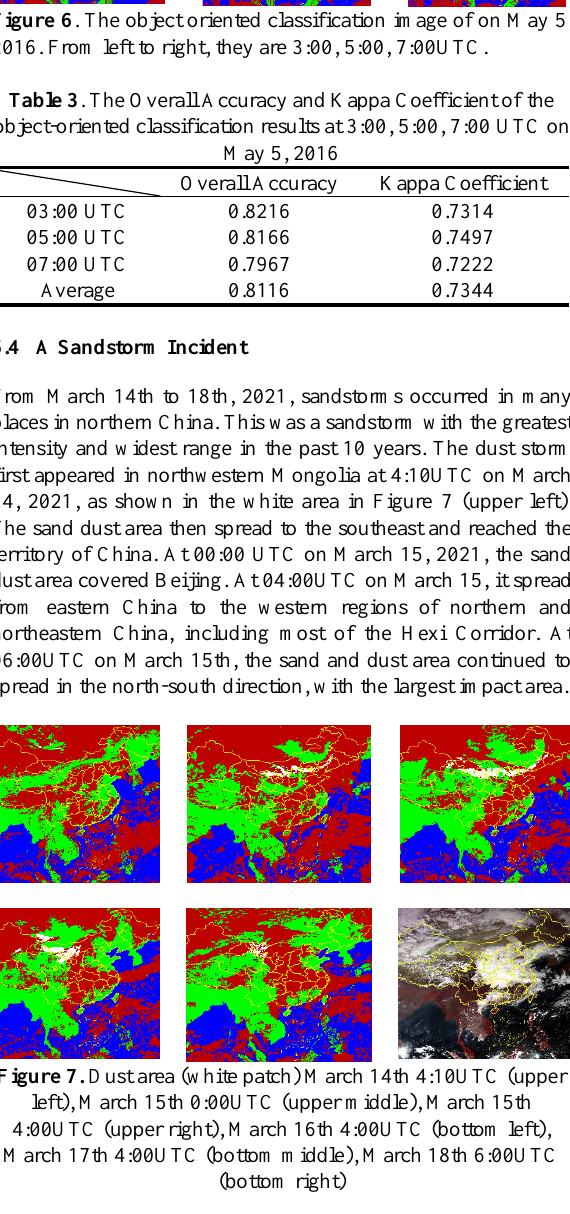
Figure 7. Dust area (white patch) March 14th 4:10UTC (upper left), March 15th 0:00UTC (upper middle), March 15th 4:00UTC (upper right), March 16th 4:00UTC (bottom left), March 17th 4:00UTC (bottom middle), March 18th 6:00UTC (bottom